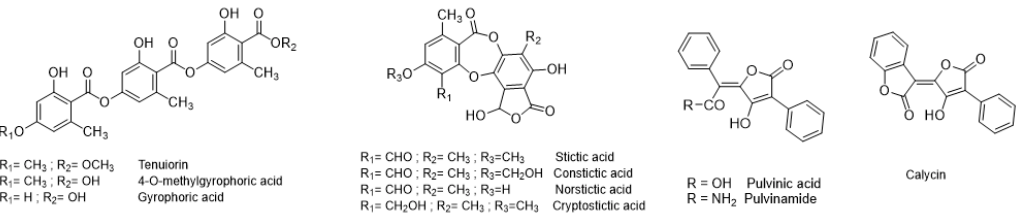
Figure 3. Structures of the phenolic specialized metabolites identified in P. crocata.